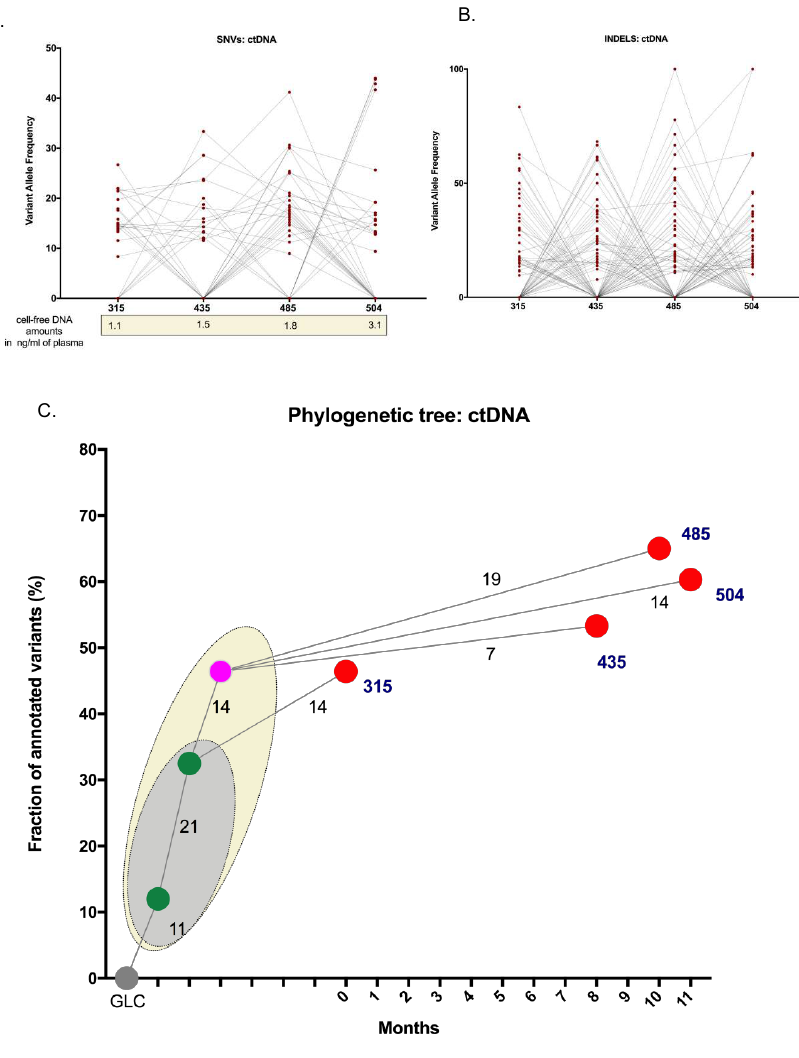
Figure 4. Clonal evolution using ctDNA. The VAFs of SNVs and INDELS were compared across the four ctDNA sampling time points. ( A ) All plotted SNVs had a COSMIC database annotation. The disappearance and emergence of the different subclones are evident and indicates the changing disease kinetics. The amount of cell-free DNA present in each sample is also indicated. ( B ) The VAFs of all INDELS identified in ctDNA samples also indicating the presence of INDELS at all time points coincident with the presence of disease in the patient. ( C ) Phylogenetic tree depicting evolutionary distances between sequential ctDNA specimens 315, 435, 485 and 504, depicted as collected at month 0, 8, 10 and 11, respectively. Evolutionary distance is defined as the fraction of common and uncommon mutations shared between the four ctDNA samples. The grey node indicates the germline (GLC). All samples have shared mutations, present in all 4 or 3 (green nodes, including the earliest sample 315), indicated by the grey oval. The pink node, represents common mutations that were shared 435, 485 and/or 504 and not found in 315, and is derived from the ancestral shared clones (shown by the light-yellow oval). The red nodes indicate the divergent clonal evolution that is private to the specific samples. The length of the individual branches denotes the proportion of mutations separating the two disease events.